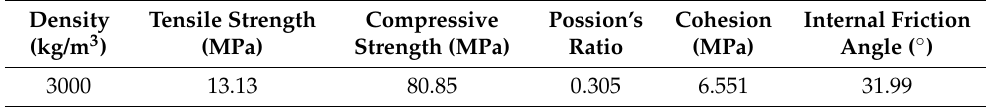
Figure 6. Section layout of the ore body. Table 1. Physical and mechanical calculation parameters of ore and rock.